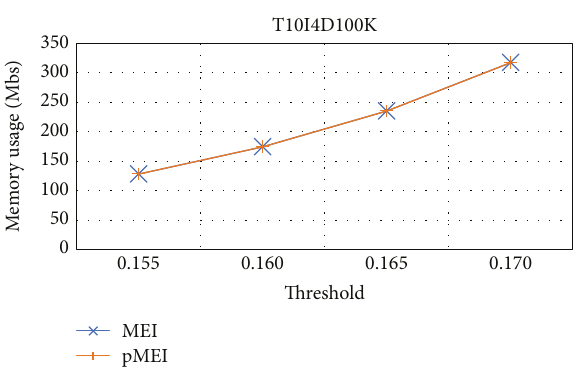
Figure 10: Memory usage of the MEI and pMEI methods on the Connect.